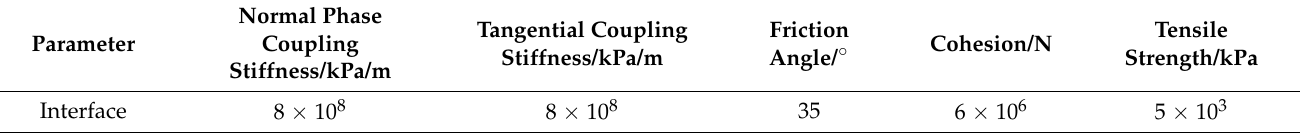
Table 4. Grout–soil interface